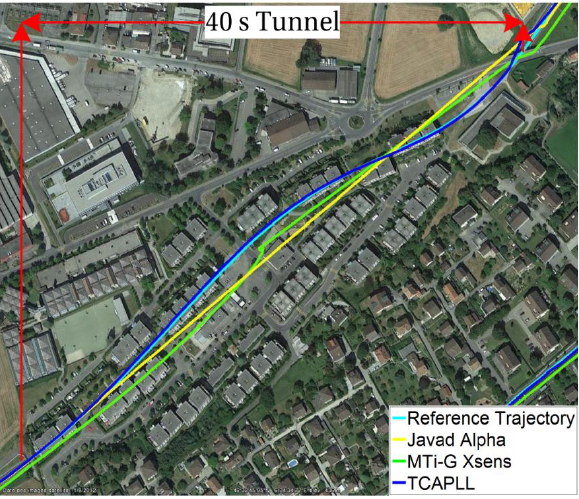
Figure 26. Position solution during the 40 s tunnel in the trajectory from EPFL to Renens center.